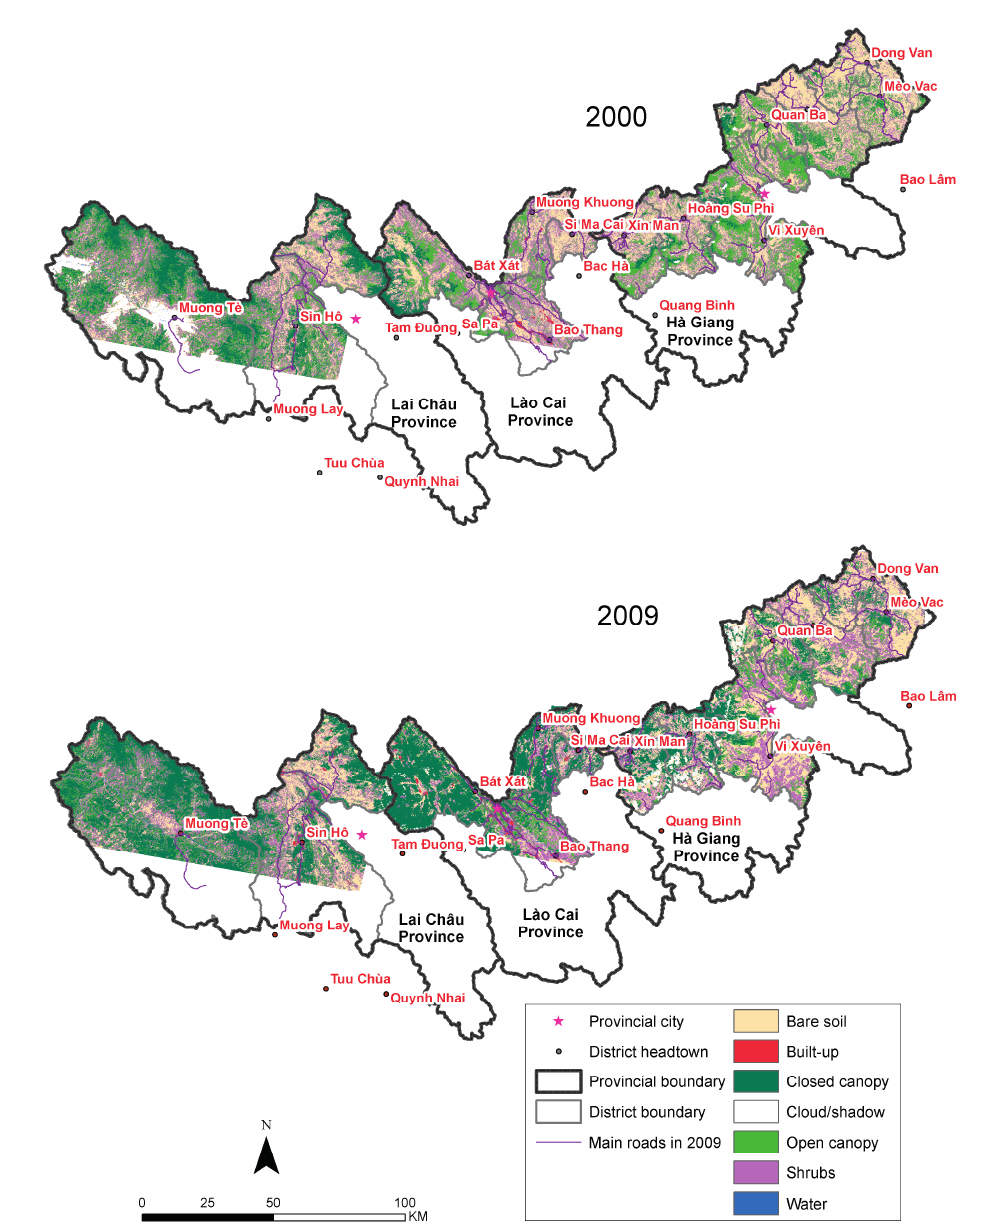
Figure 4. Land cover maps for the region, 2000 and